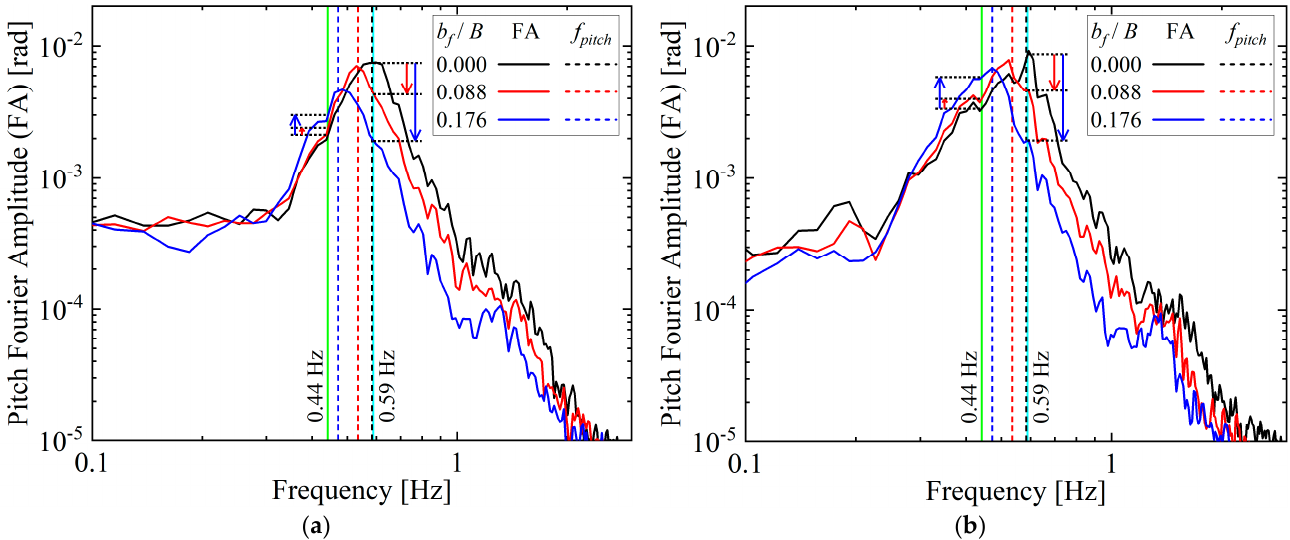
Figure 21. Fourier amplitude (FA) of the pitch for the irregular waves: ( a ) f s = 0.59 Hz; ( b ) f s = 0.44 Hz.